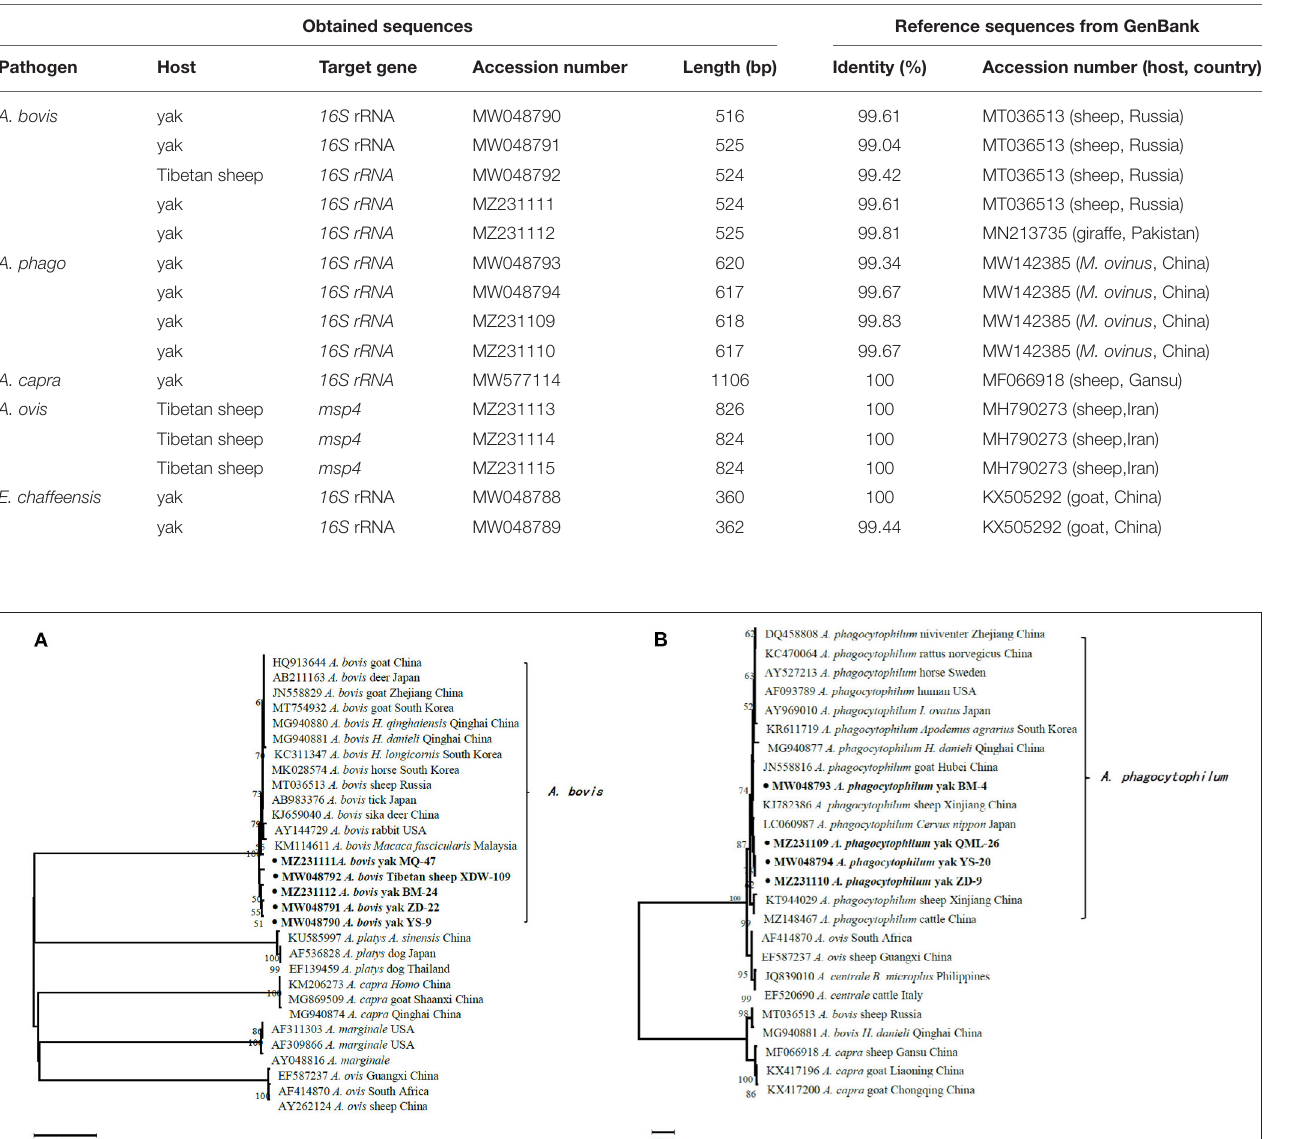
TABLE 3 | The DNA sequences submitted to the gene bank in this study.